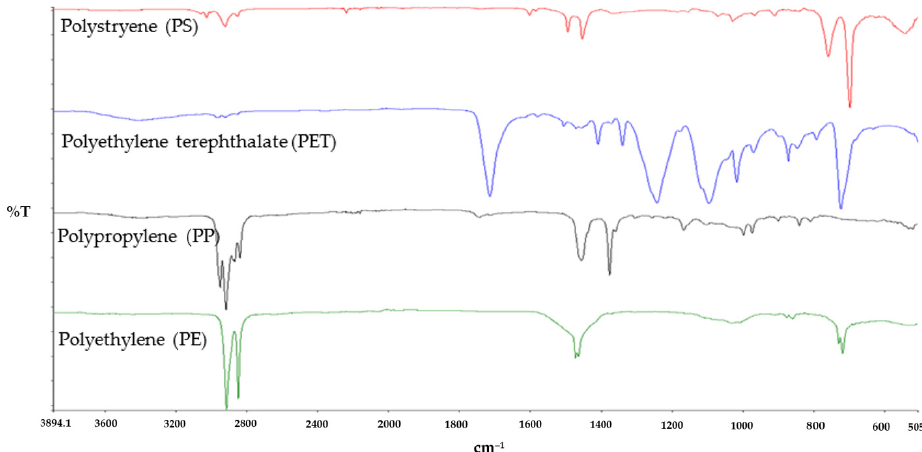
Figure 7. FTIR spectra of plastics found on both beaches. 405060 Figure 8. Percentages of plastic fragments pooled from ODEC and Kebagu beaches, from FTIR anal- ysis . Analysis of the types of plastics that can be tracked back to their sources is important as it contributes useful information on individual items of plastic debris [24]. Results from Fourier-transform infrared (FTIR) spectrometer analysis showed that PP and PE were the more dominant types of plastics compared to other polymers. Overall, the collected plastic debris from ODEC and Kebagu beaches consisted mostly of polypropylene and polyeth- ylene. PP and PE tend to be positively buoyant and easily deposited on beaches because of their specific gravity of less than one [25]. The results of analysis showed that PE and PP were the highest in abundance, which is not surprising, since PE, with an annual global production of around 80 million tonnes, is mainly used to manufacture packaging (plastic 01020 30